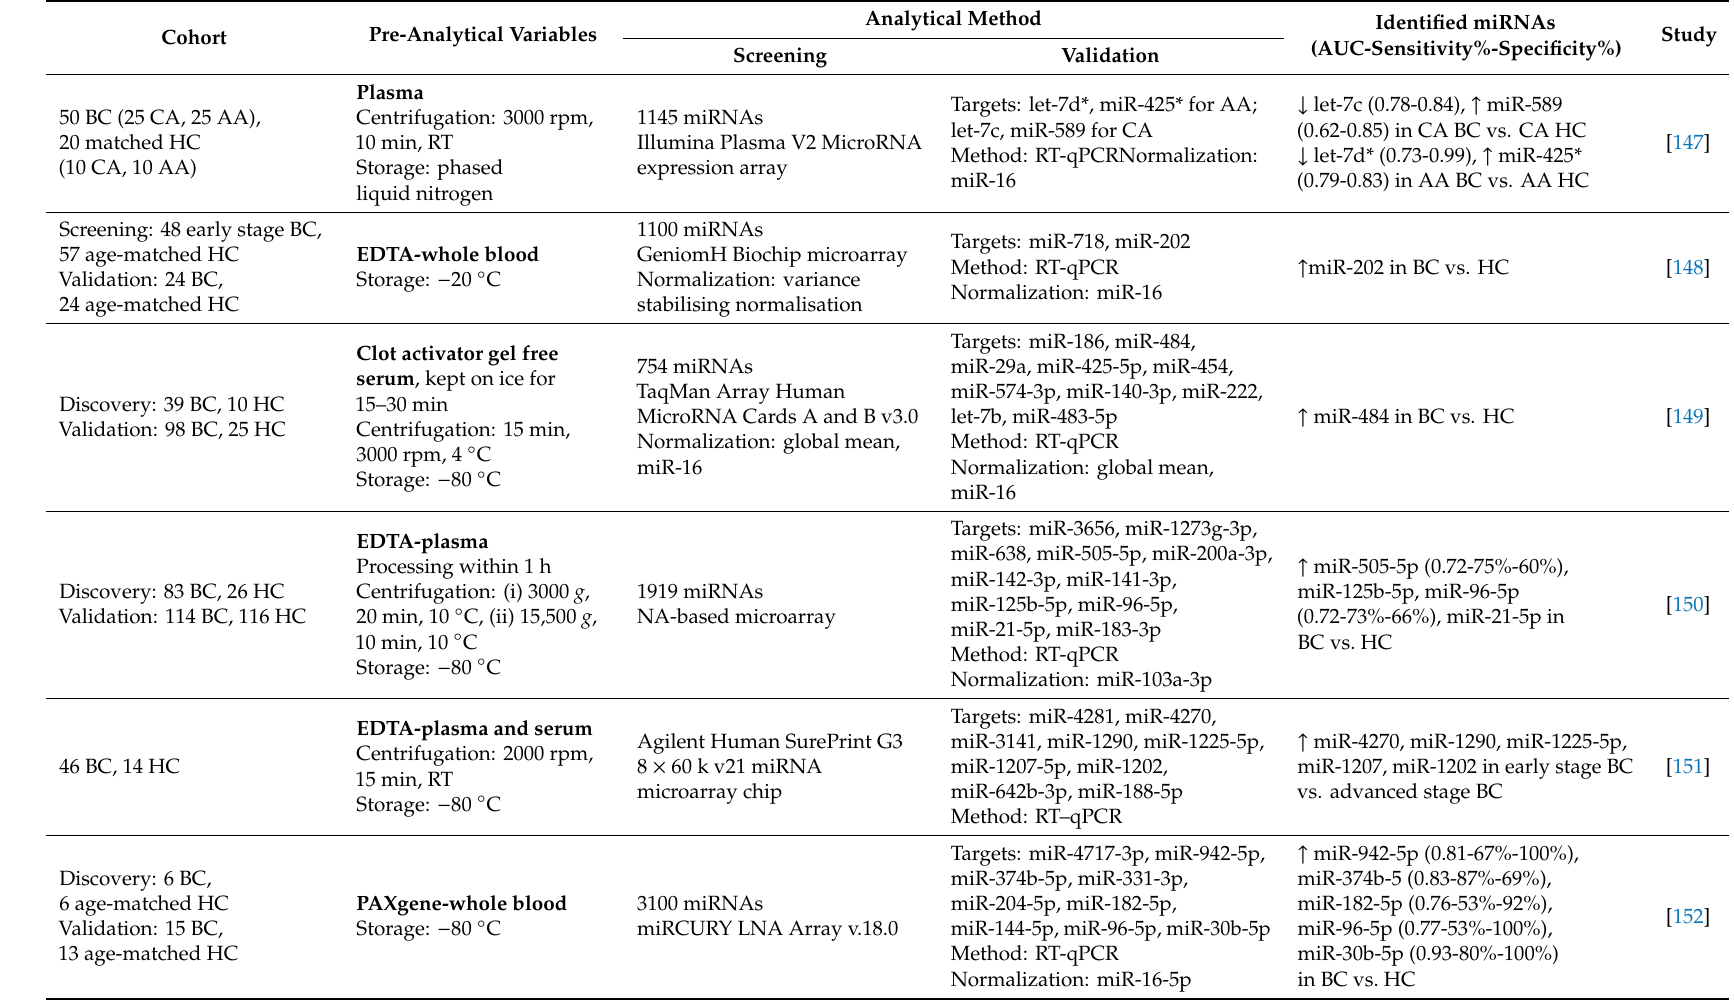
Table 2. Circulating miRNAs associated with breast cancer